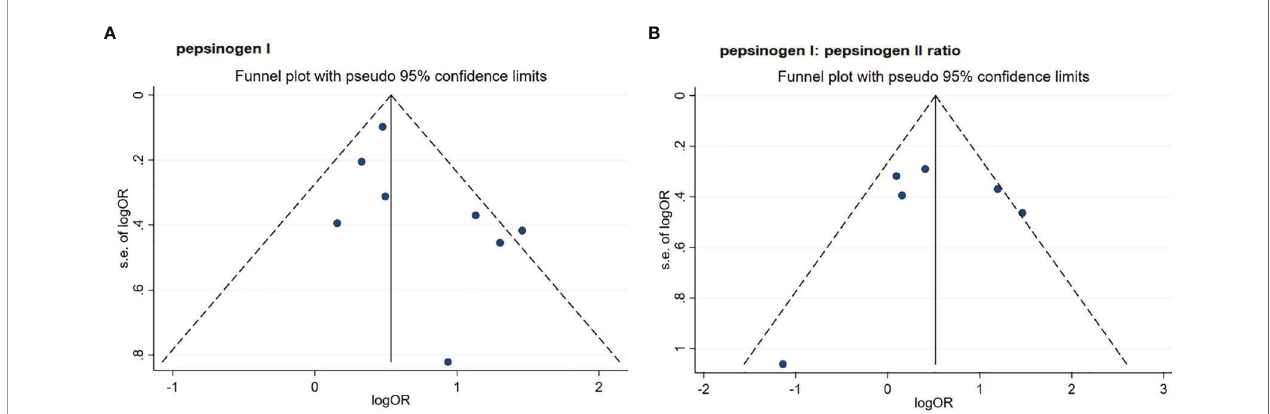
FIGURE 3 | Funnel plots of standard error by log odds ratio for the association of PGI (A) and PGR (B) with risk of esophageal squamous cell carcinoma. (A) pepsinogen I; (B) pepsinogen I: pepsinogen II ratio. PGI, pepsinogen I; PGR, pepsinogen I: pepsinogen II ratio; OR,